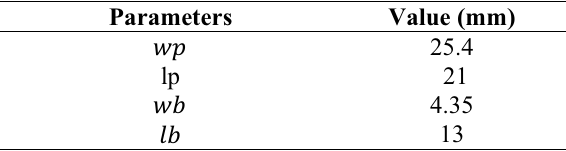
Fig. 2. Conventional patch coupler design Table 1. Dimensions of the conventional patch coupler